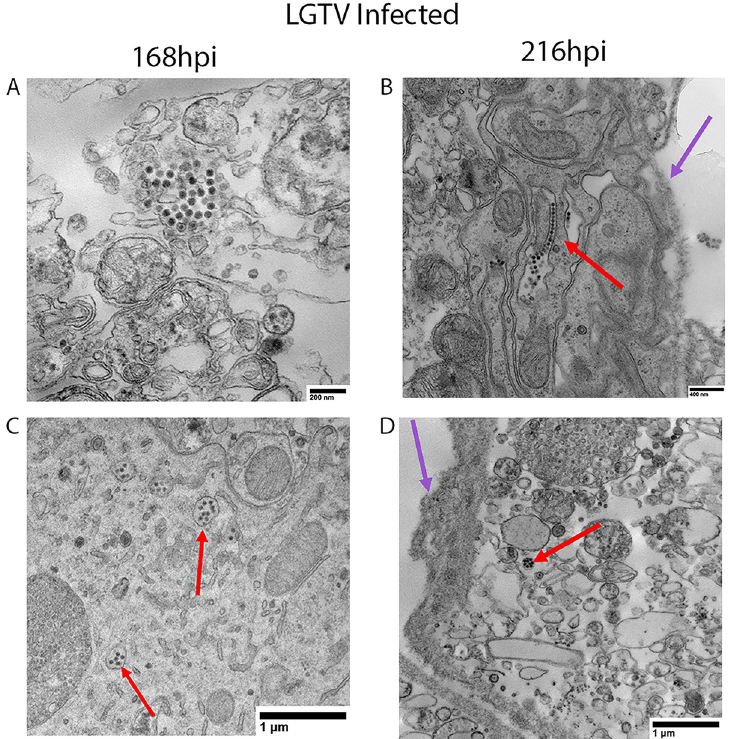
Fig 7. Transmission electron microscopy of LGTV-infected SG cultures from male ticks. Male Ixodes scapularis salivary gland (SG) culture samples were prepared for transmission electron microscopy at 168 hours post infection (hpi) and 216hpi. Each image displays a single SG from a pool of 3 SG pairs per experimental group. In LGTV-infected samples, virus particles were packaged in single-membrane-bound compartments (A, C, and D) or extracellular (B) and had a diameter of approximately 41-42nm. Red arrows indicate virus particles and purple arrows denote the lumen of the acinus. Panel B displays virus particles that appear to be extracellular.